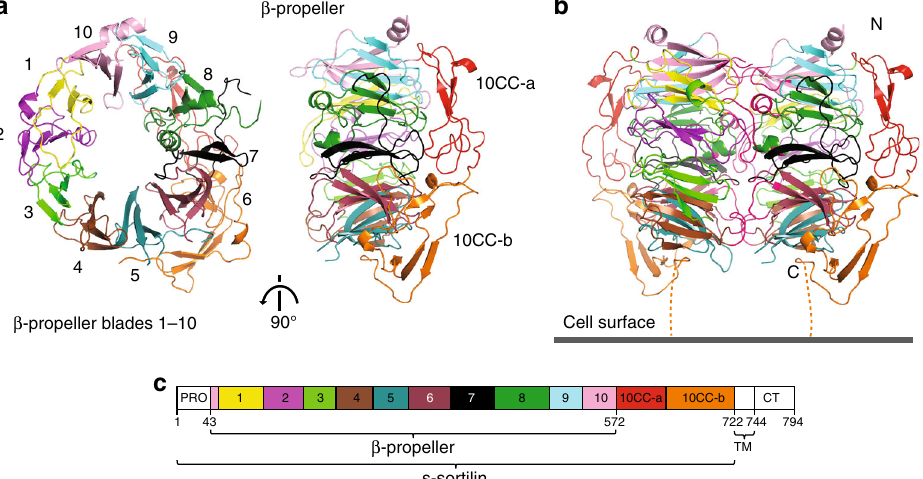
Fig. 1 Crystal structures of s-sortilin at acidic pH reveal a dimer. a Cartoon representation of a single chain from the mouse s-sortilin dimer viewed from the top face of the β -propeller (left) and from the side (right), domains numbered and colored according to scheme C. b Side-view of the crystallographic s- sortilin dimer and its proposed orientation on the cell surface. Termini are indicated by N and C. The nine residues missing from the structure to the cell surface are indicated with a dotted line. c Schematic domain organization of mouse sortilin. PRO, prodomain; TM, transmembrane region; CT, cytosolic tail. The domains present in the structures are